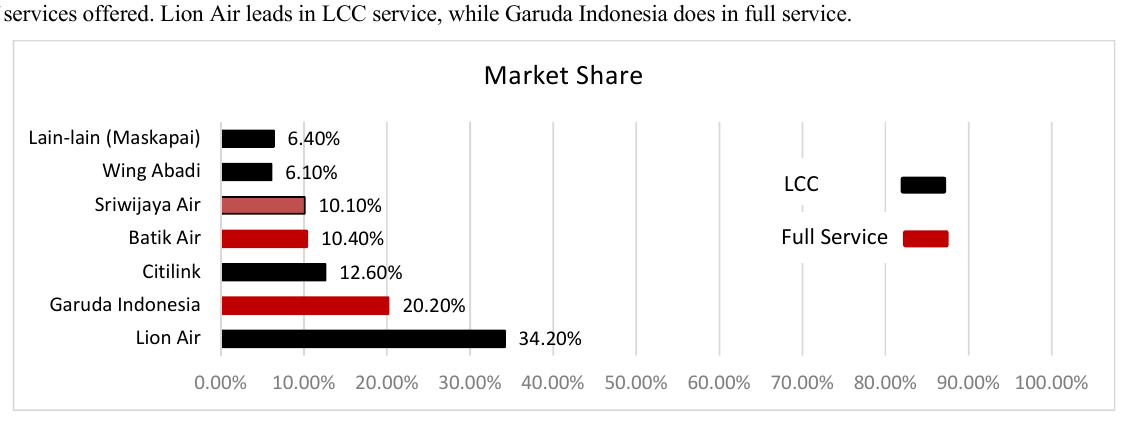
Fig. 1. Passengers and Domestic Market Share of National Airlines in 2017 Source: Directorate General of Civil Aviation